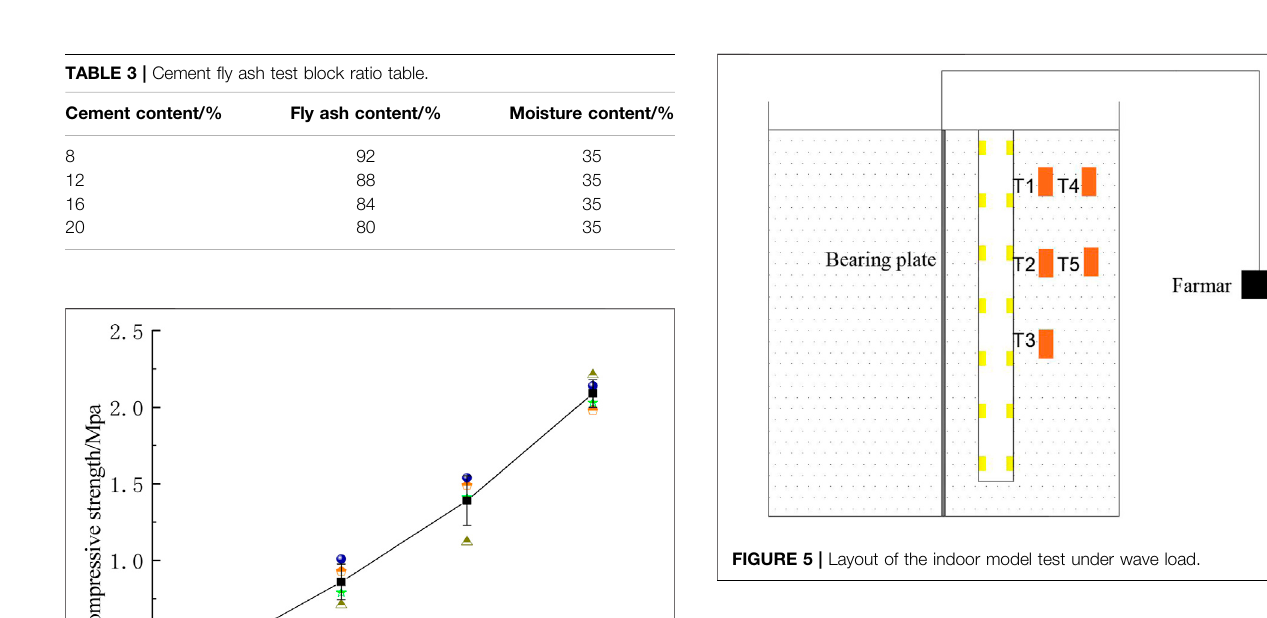
FIGURE 3 | Field engineering test of CFMP- fl y ash composite foundation.